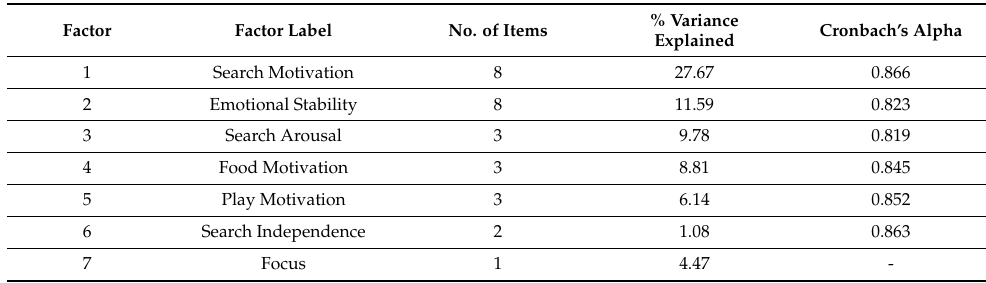
Table 4. Factor labels and internal consistencies of items with the highest loading onto